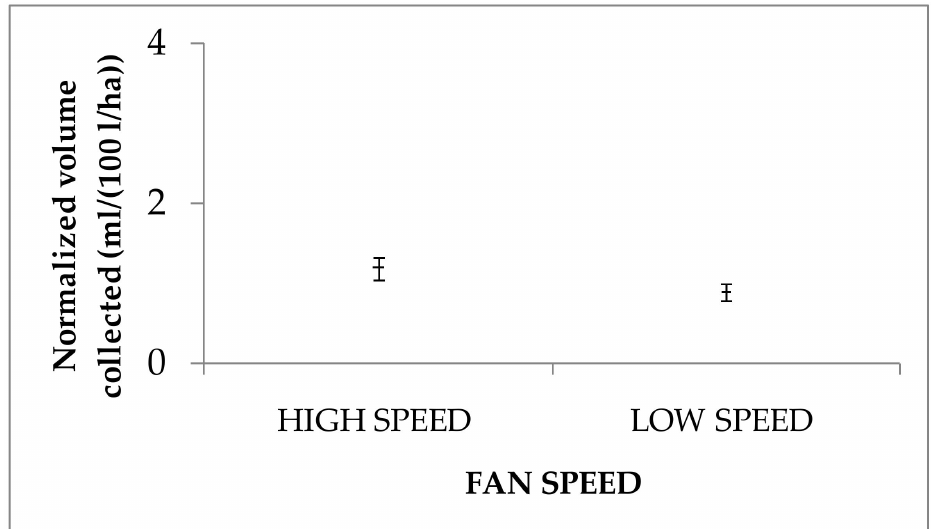
Figure 14. Fan speed effect on the normalized volume collected above the Canopy height (mean ± SE) with the T